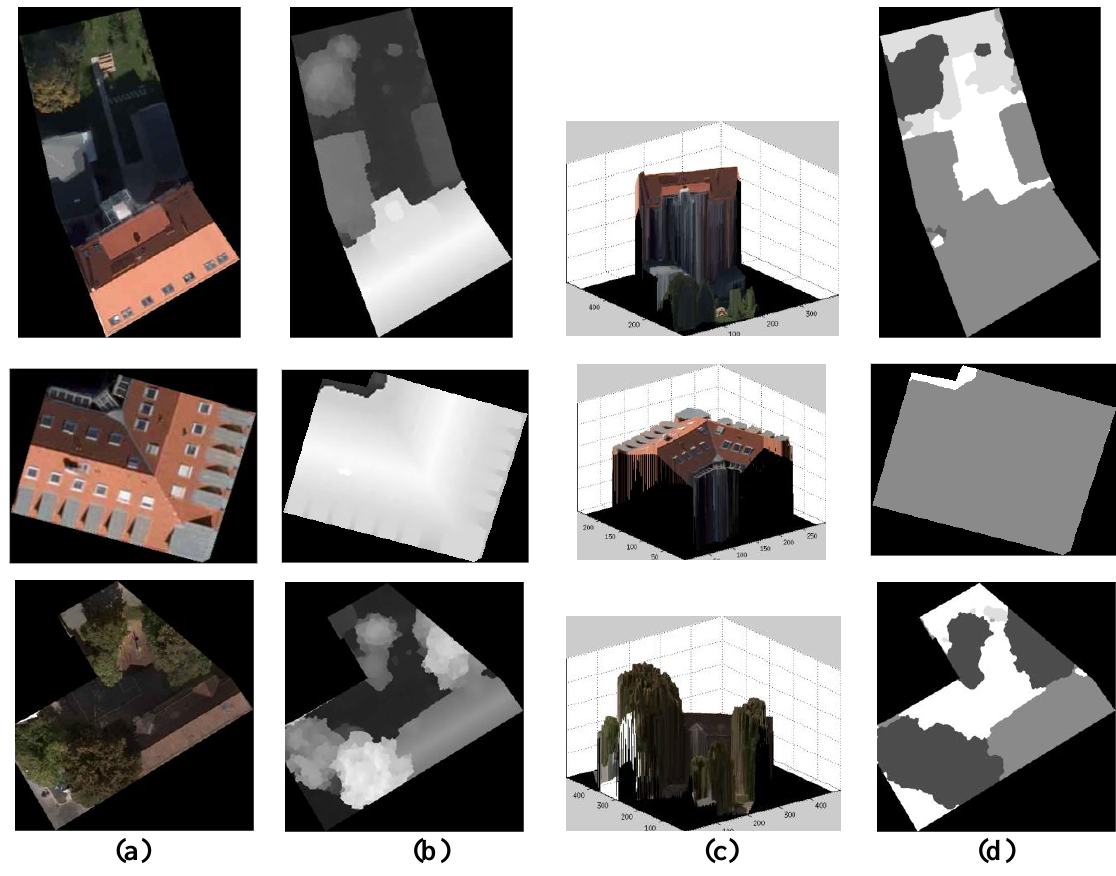
Figure 9. Three separate sample properties and the source data per property. To the left in column ( a ) are the orthophoto segments. In column ( b ) are the elevation data (DSM), in column ( c ) are the elevations on top of the Bald Earth. Column ( d ) shows the classification result with seven object